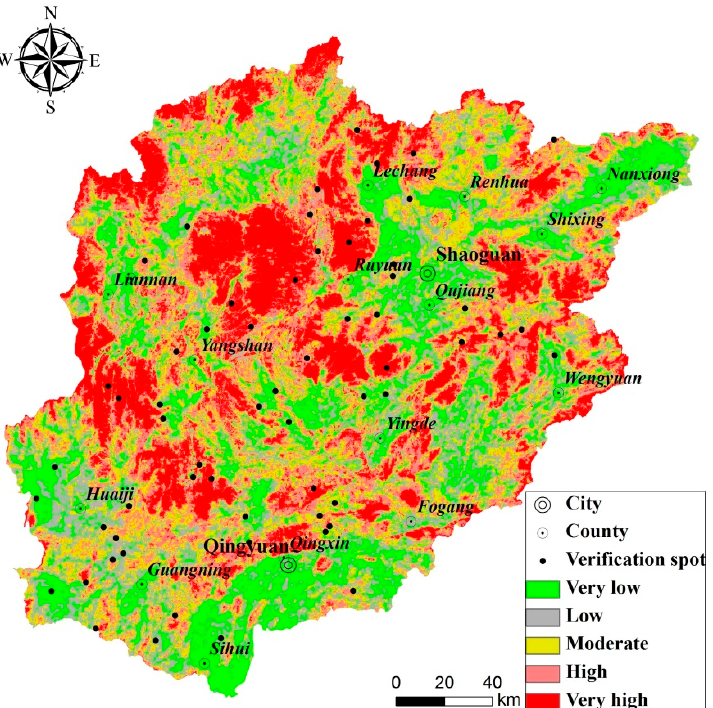
Figure 7. Landslide susceptibility map based on RFW in the Beijiang River Basin.